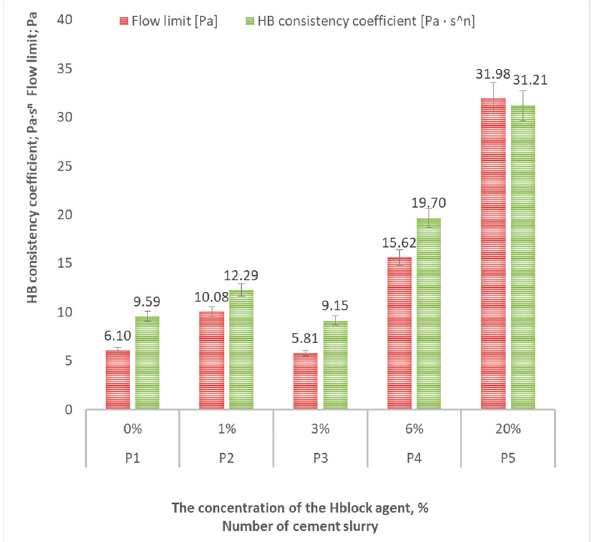
Figure 14. Summary of selected test results for rheological parameters of cement slurries (cement class CEM I 42.5R).